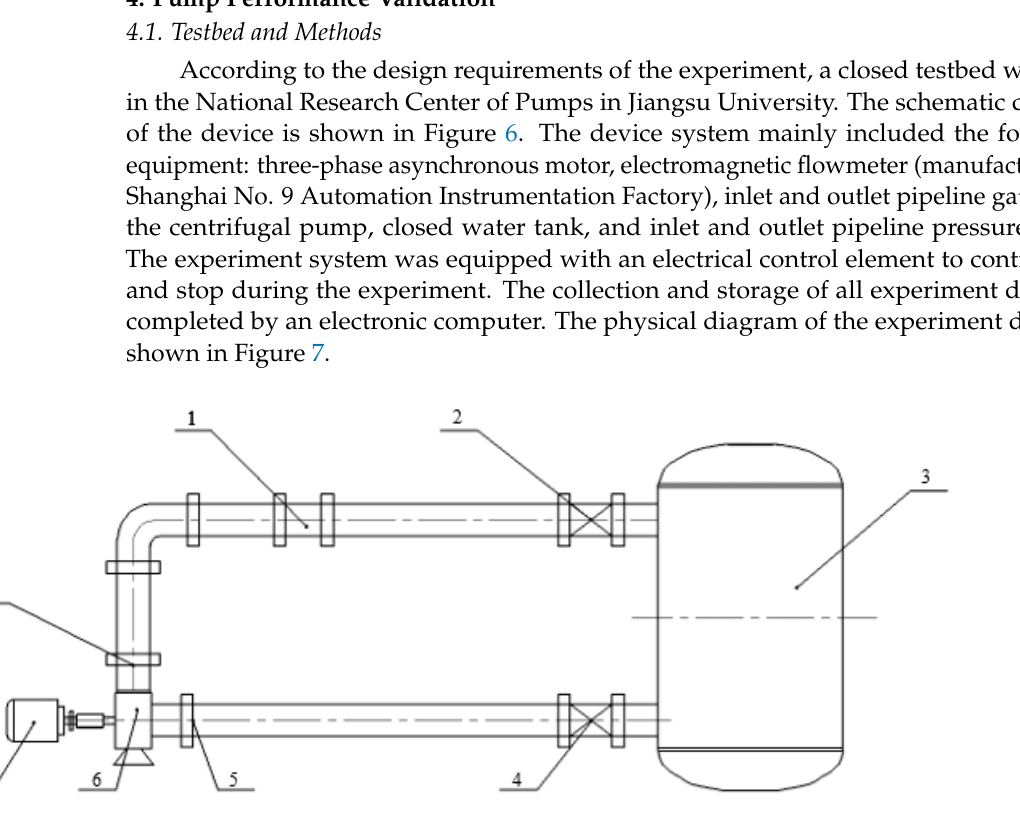
Figure 7. Test bed. After the test and simulation to obtain the basic data of pump operation, the formula for calculating the pump head is: H = (p 2 − p 1 )/ ρ g + (V 2 2 − V 1 2 )/2g + (Z 2 − Z 1 ) where p 1 and p 2 are the pressure of the fluid at the pump inlet and outlet, in Pa. V 1 and V 2 are the velocity at the inlet and outlet of the pump, in m/s. The diameters of the import and export pipelines are the same, so the import and export flow rates are the same. Z 1 and Z 2 are the heights of the inlet and outlet, in m. In the test system, the heights of the inlet and outlet are the same. ρ is the density of the fluid, in kg/m 3 . g is the acceleration of gravity, in m/s 2 . The formula for calculating the hydraulic power of the pump is: P 1 = 9800 × Q × H/3600000 where P 1 is the hydraulic power of the pump, in kW. The shaft power obtained in the numerical calculation is: P 2 = n × T/9552 where P 2 is the numerical shaft power of the pump, in kW. T is the numerically predicted torque. The input power of the motor in the test system is: P 3 = U × I